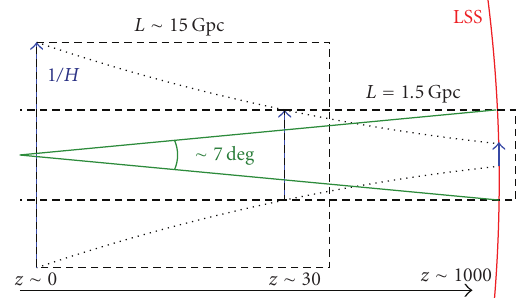
Figure 12: Stacking of two numerical simulations to compute the small angles CMB anisotropies induced by NG strings [197]. The dashed rectangles represent the redshift and angular extension of two numerical simulations used to evaluate (52). The first starts at last scattering and stops at z (cid:2) 30 while the second starts at z (cid:2) 30 and ends now, up to a small overlapping to ensure relaxation towards